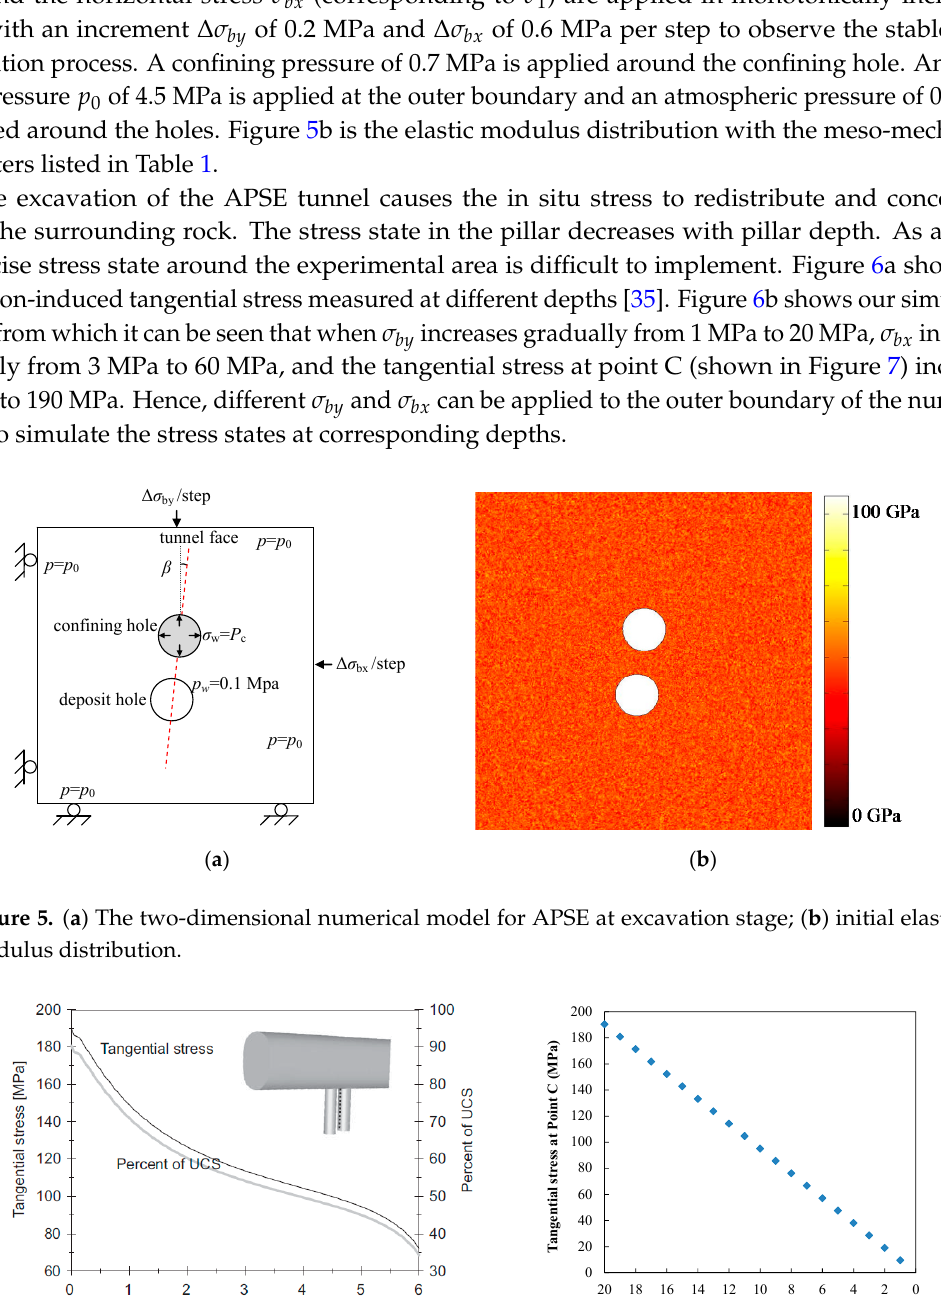
: Heating point; : Temperature monitoring point. Figure 7. Numerical model for APSE at heating stage. 3.5. Numerical Model for Heating Stage After the excavation stage, four heating holes are drilled further to simulate the heating stage (Figure 7). Heater powers used in the experiment and in the numerical simulation are listed in Table 3. The temperature at the outer boundary is set to the initial rock formation temperature 0 T of 15 °C. A natural air convection boundary is set on the surface of the deposit holes. The heater powers used in the simulation are based on the report and a related study [35,36]. In addition, an initial water pressure 0 p of 4.5 MPa is applied at the outer boundary and an atmospheric pressure of 0.1 MPa is applied around the holes. Outer boundary stresses